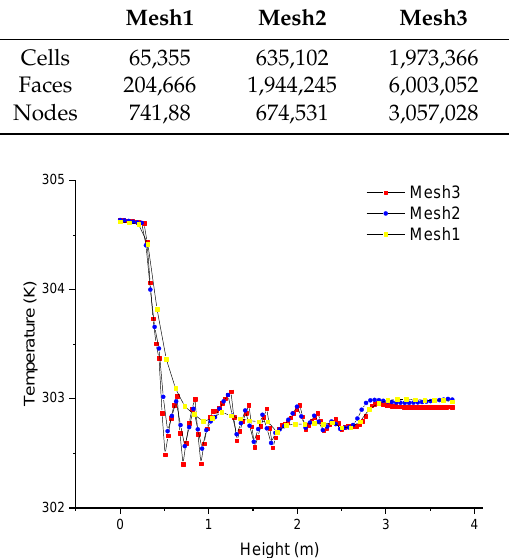
Figure 7. Temperature profiles along the vertical line for mesh1, mesh2 and mesh3.